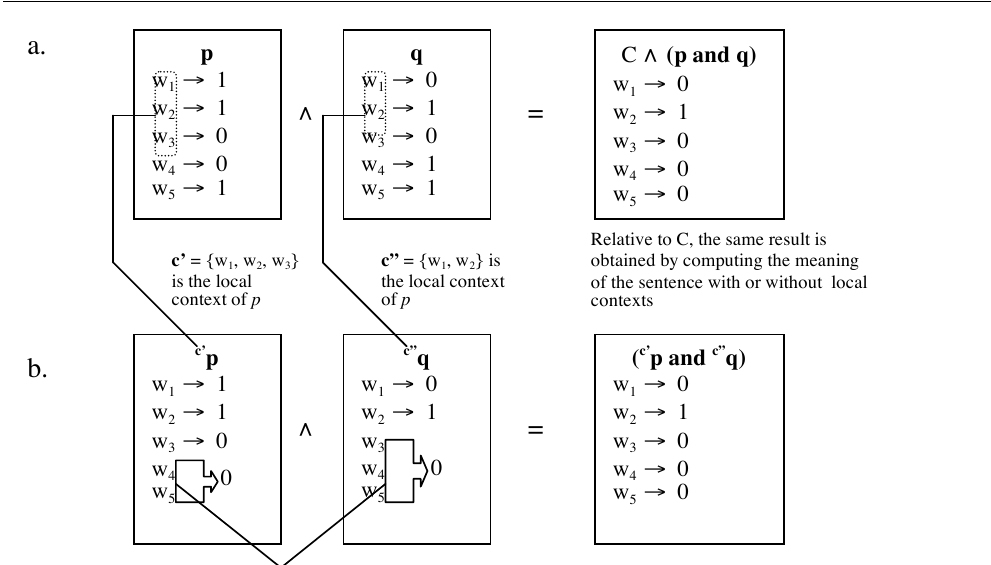
Figure 1 Computation of the meaning of (p and q) relative to C = { w , w , w 1 2 3